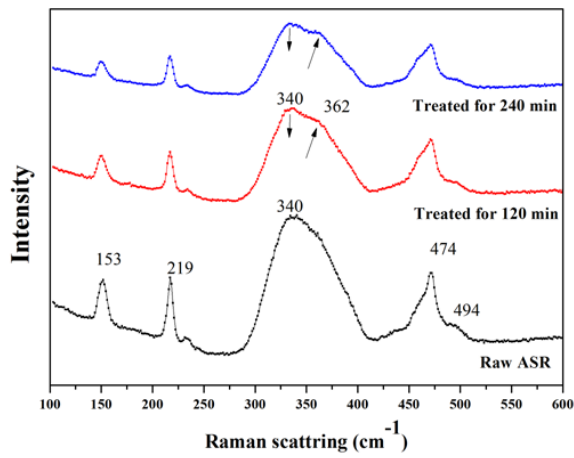
Figure 5. The Raman spectra of the raw and treated HB-ASR.